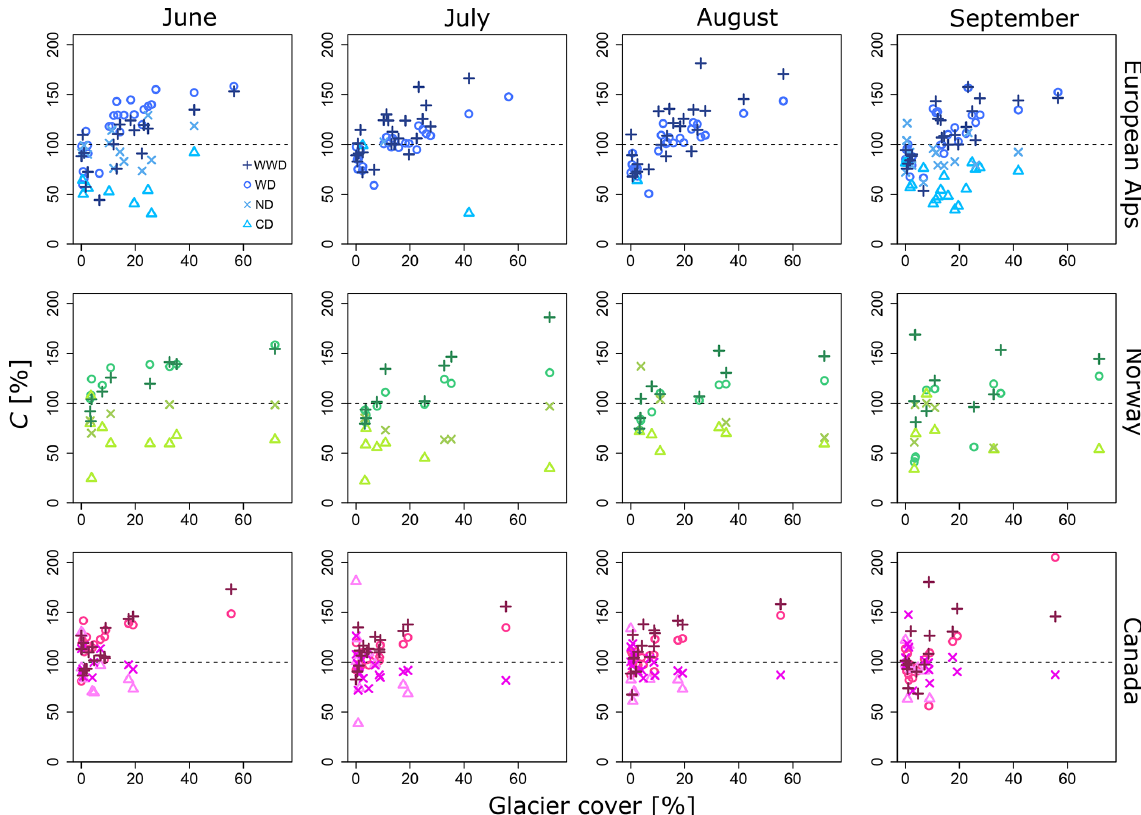
Figure 6. Mean catchment level of compensation ( C ) during WWD, WD, ND, and CD events in different regions (rows) and months (columns). If all types of dry periods occurred in the time series of a particular catchment, one catchment shows four symbols in a vertical line.